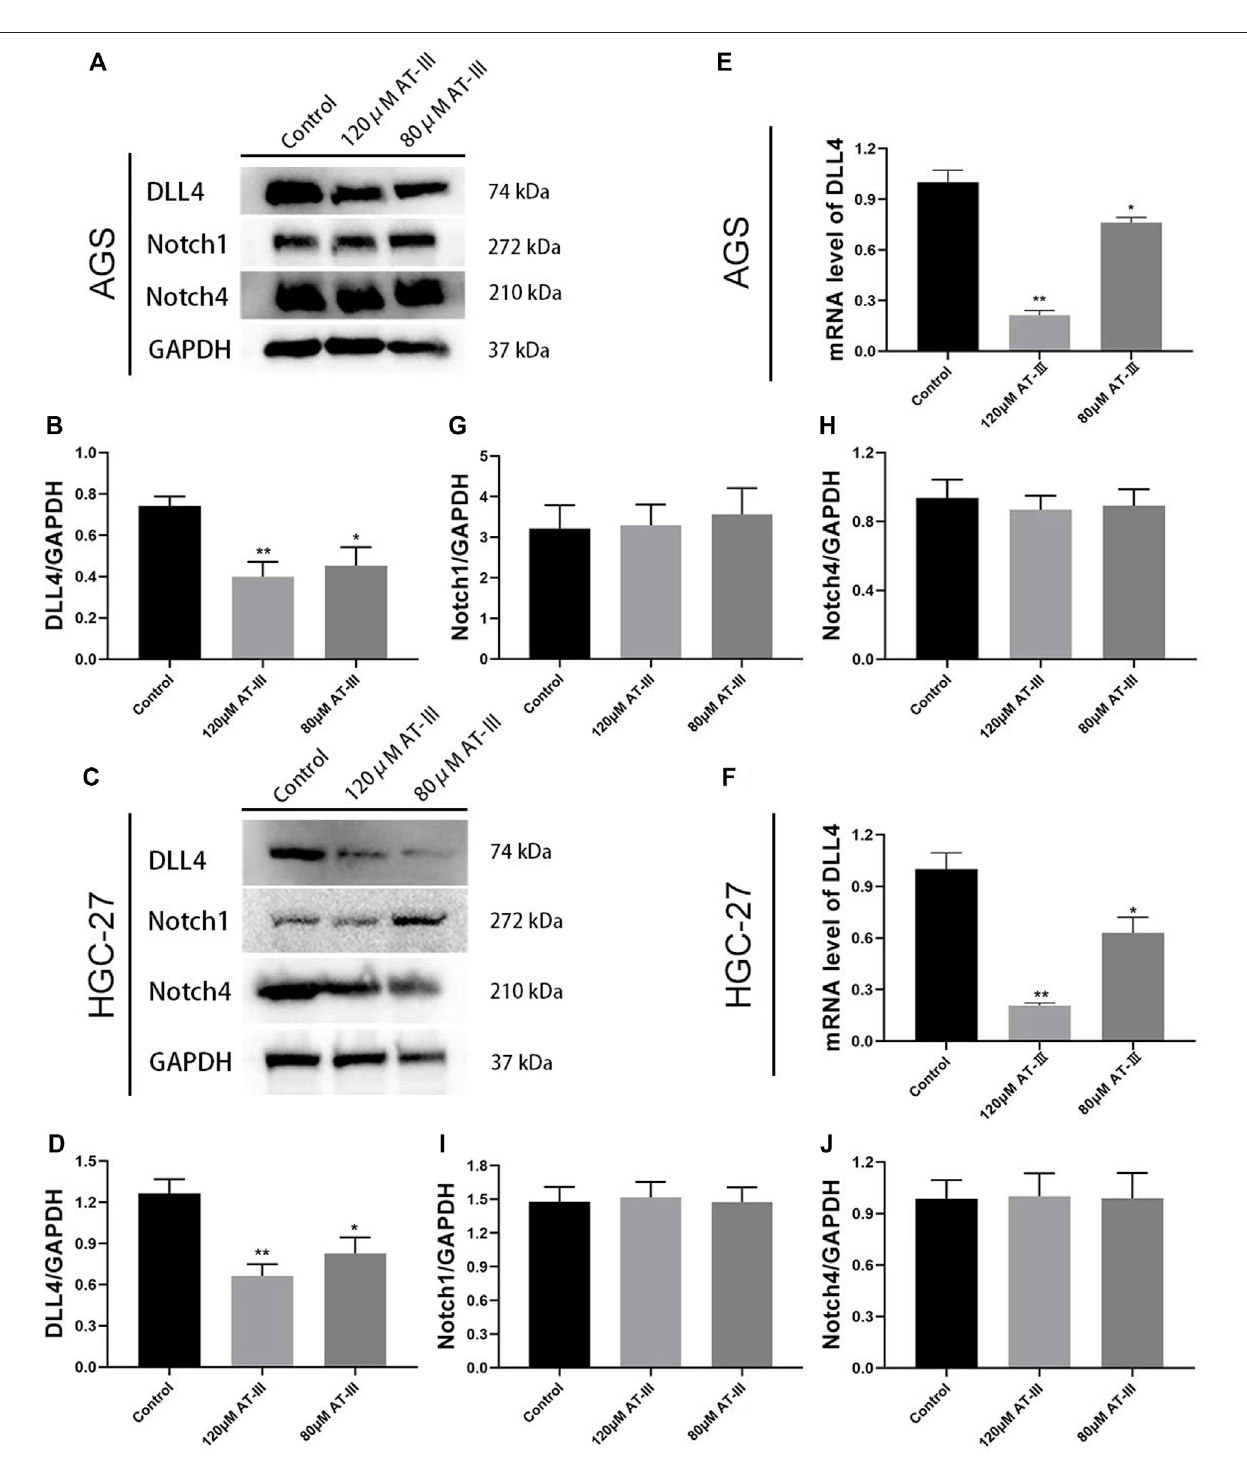
FIGURE6| RepresentativewesternblottingbandsofDLL4,Notch1andNotch4intransfectedAGS (A) andHGC-27 (C) cells.QuantitativeanalysisofDLL4 (B,D) , Notch1 (G,I) , and Notch4 (H,J) in western blotting bands ( n = 9). RT-qPCR detection for DLL4 mRNA levels in transfected AGS (E) and HGC-27 (F) cells ( n = 3). * p < 0.05, ** p < 0.01 versus the control group. Data are presented as mean ± SEM. AT-III, Atractylenolide III; SEM, standard error of mean.